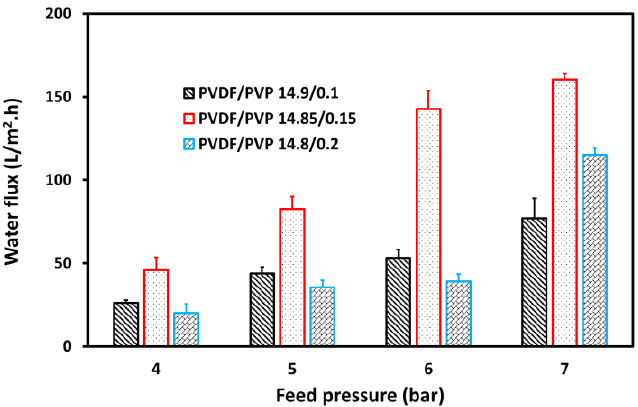
Figure 6. Water flux at various feed pressures in the UF process for tofu wastewater.